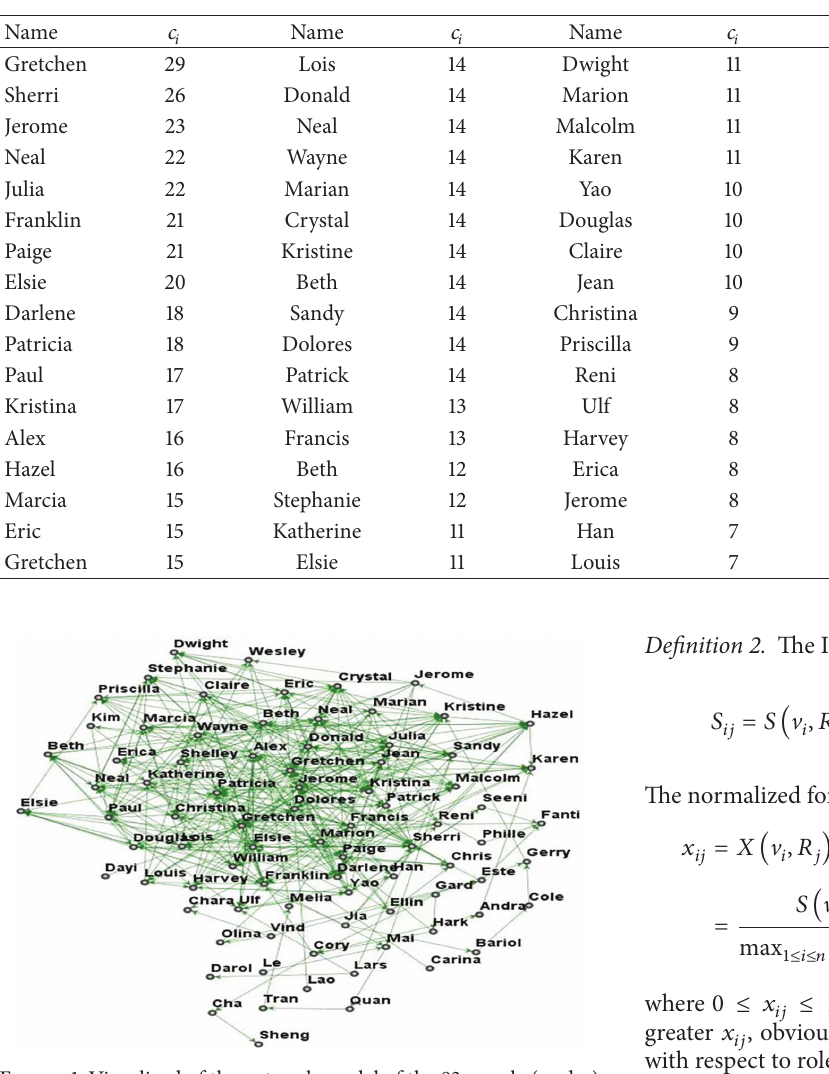
Figure 1: Visualized of the network model of the 83 people (nodes) and 400 messages between these people